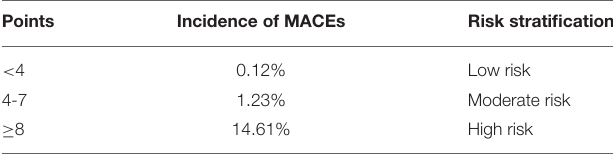
diseases, DM, and HT), and three laboratory results (HGB, TABLE 7 | Risk stratification using HASBLAD Score in validation